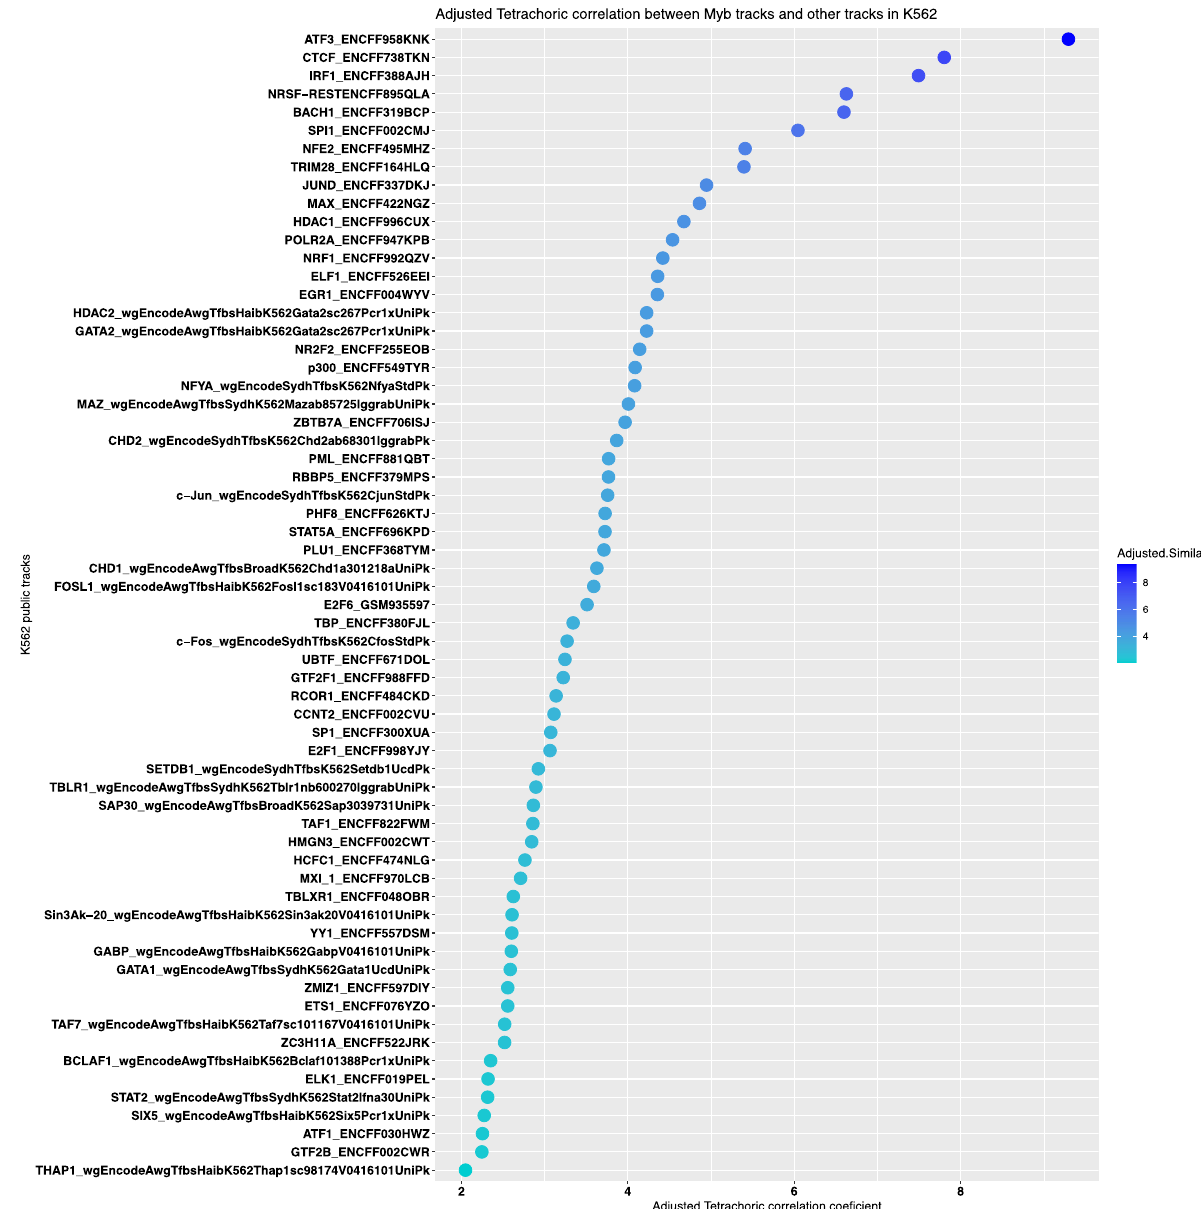
Figure 6. Co-localization of MYB with other TFs, co-factors and proteins of genomic relevance. Co-localization analysis of MYB ChIP-seq peaks with publicly available ChIP-seq data from K562 was made using the GSuite HyperBrowser (https:// hyper brows er. uio. no/). The tetrachoric correlation was used as a pairwise similarity measures between genomic intervals from MYB and that of the publicly available targets for K562 (Supplementary Table S1). The resulting correlation table was used to generate the dotplots using the R environment v3.6.1 and ggplot2 package